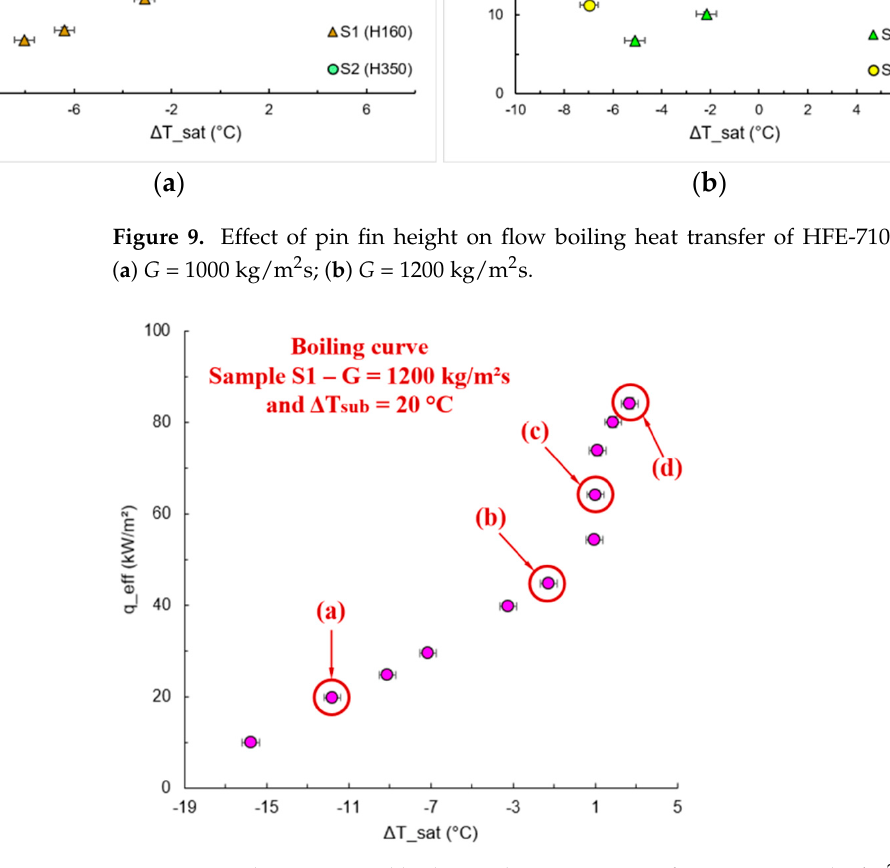
Figure 10. Boiling curve and high-speed camera images for S1. G = 1200 kg/m 2 s and Δ T sub = 20 °C.